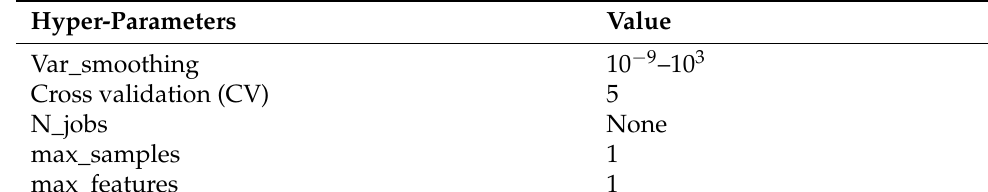
Table 9. Input Parameters for Bagging.